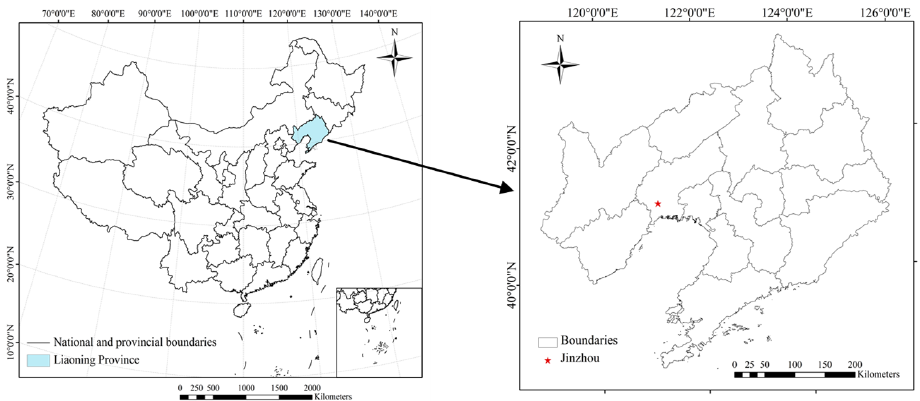
Figure 1. Location of the study site in the maize belt of northeast China.